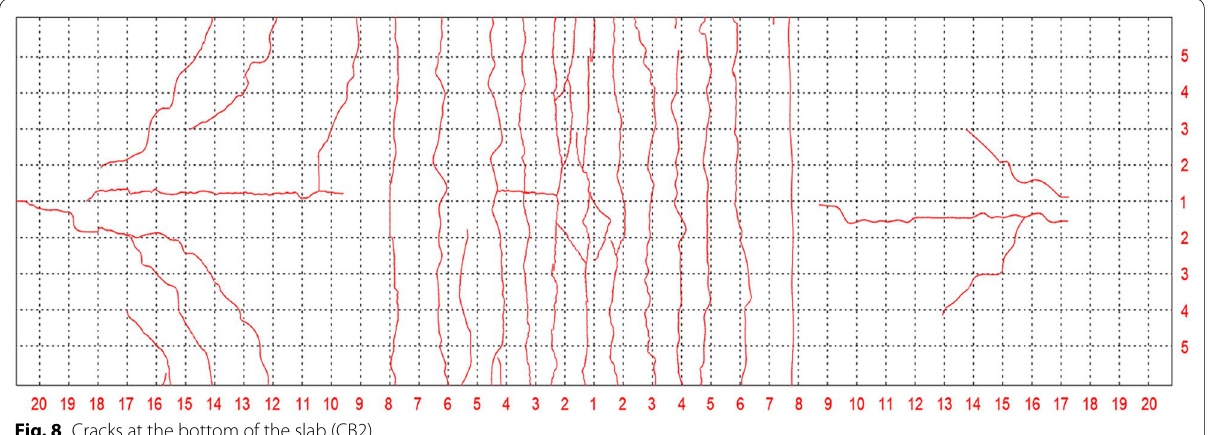
Fig. 8 Cracks at the bottom of the slab (CB2).